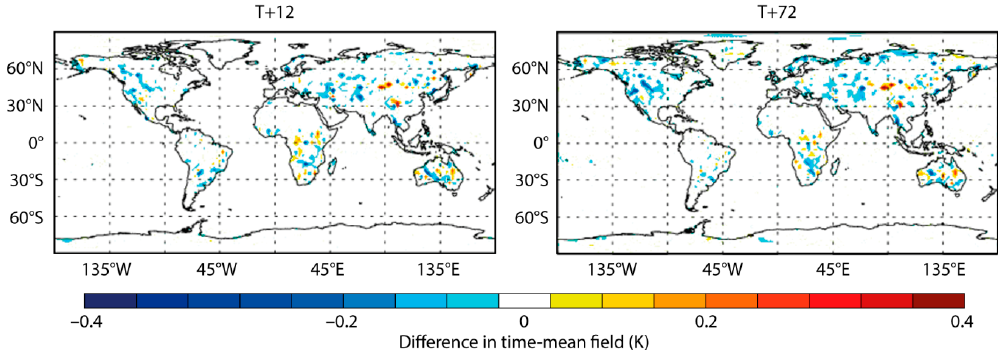
Figure 6. Impact, shown as mean temperature difference in K (01 December 2016 to 28 February 2017), of doubling snow observation error in the ECMWF snow data assimilation system used for NWP, on two-meter air temperature 12-h and 72-h forecasts.